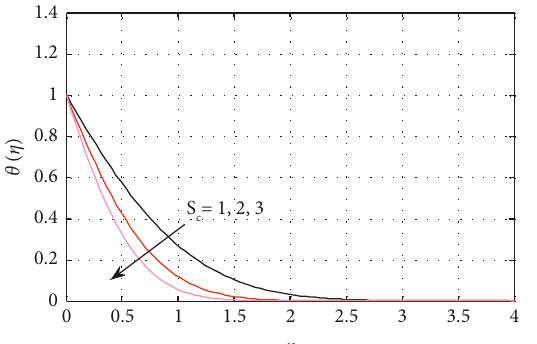
Figure 8: Impact of the Schmidt number on the concentration profile using A � 1 ,v � 0 . 4 ,Gr